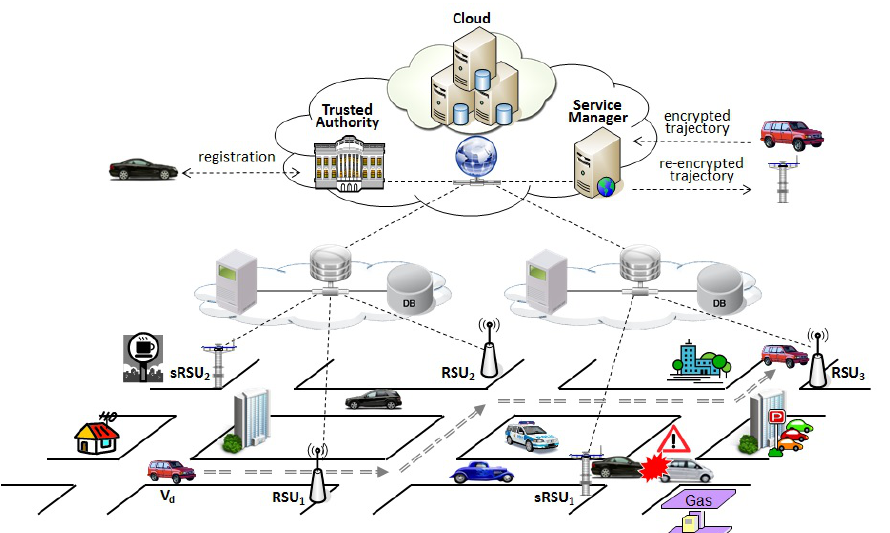
Figure 2. System